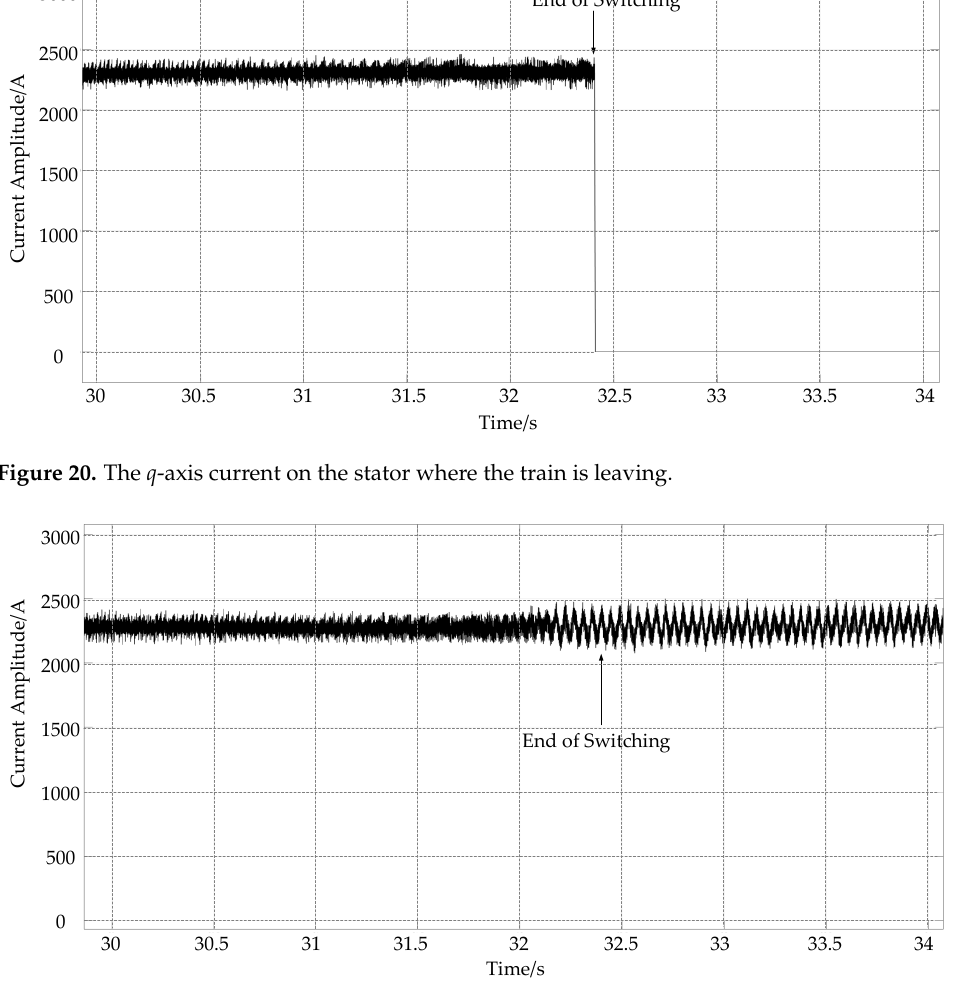
Figure 22. Train thrust during switching.